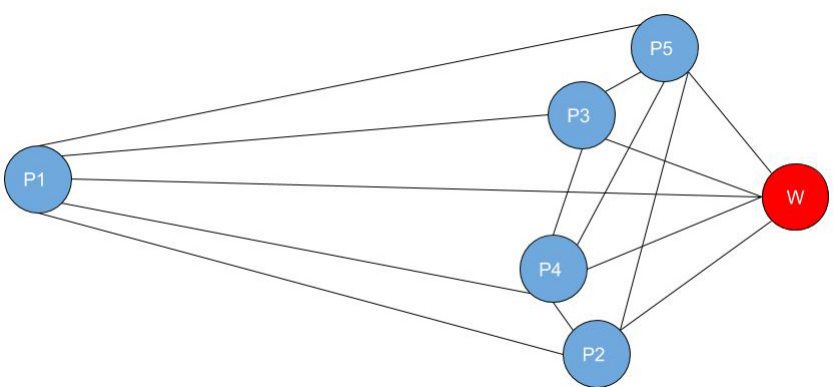
Figure 6. Topological graph of distances between home and work locations of